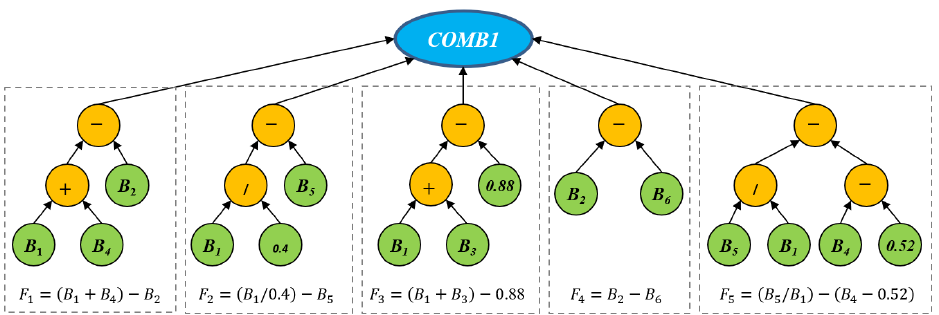
Figure 3. An example tree of the proposed GP method with the COMB1 function. This tree can produce five features, and each feature is constructed by using arithmetic operators and input bands (terminals).